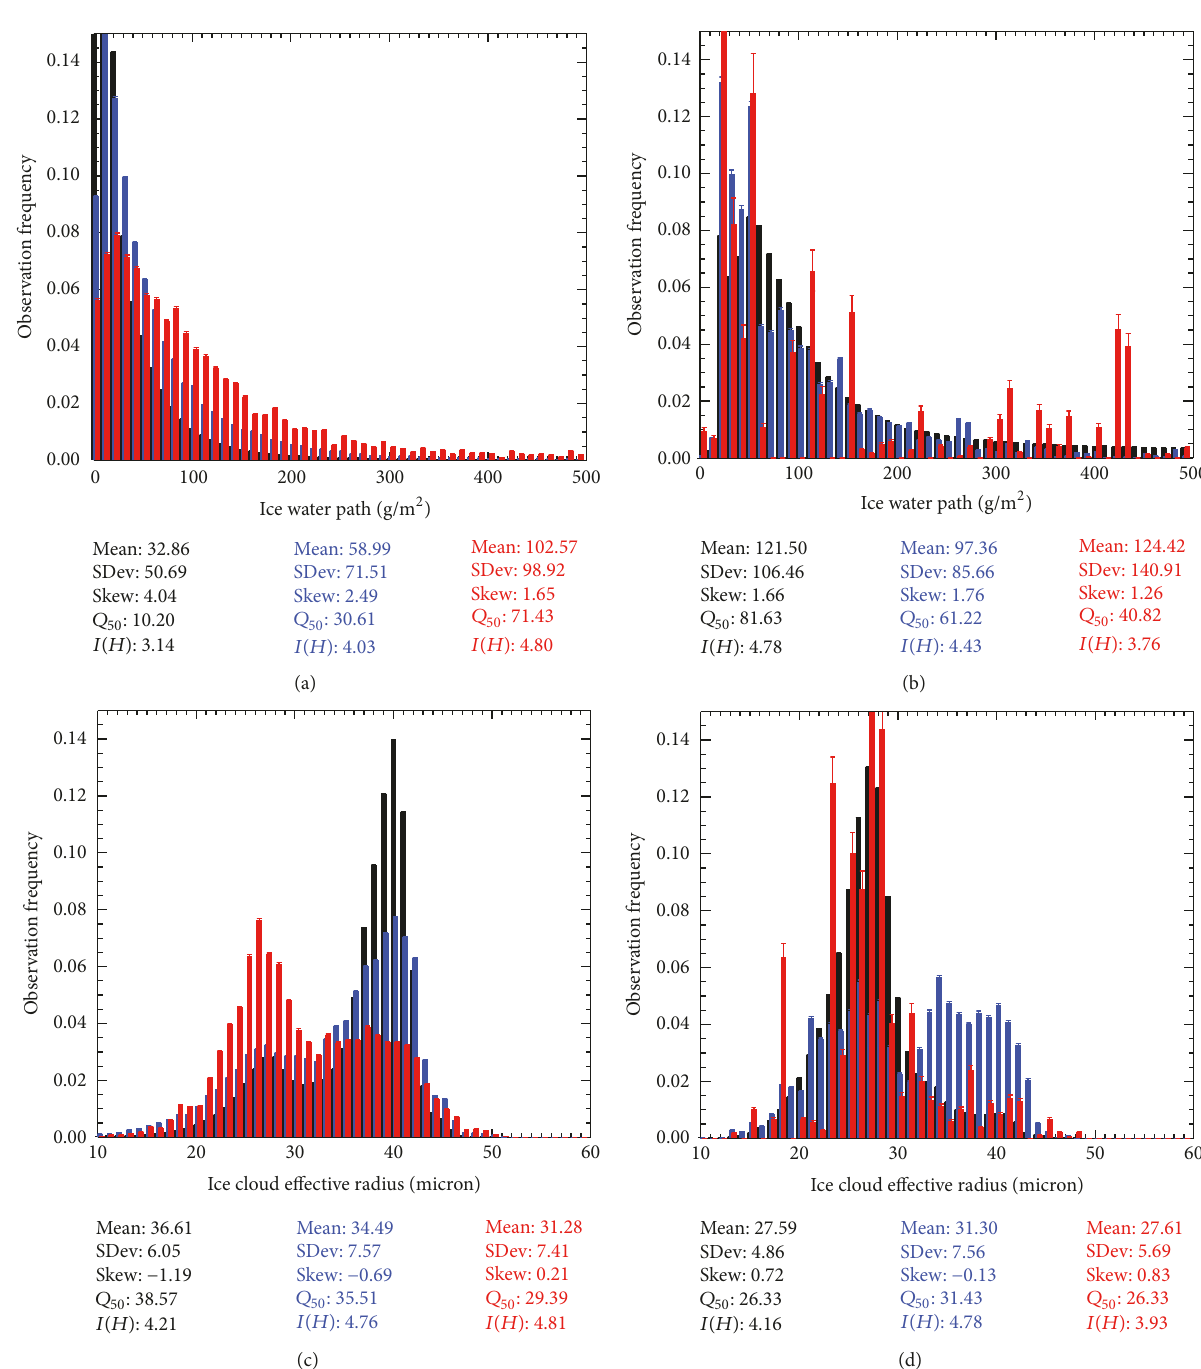
Figure 8: Observation histograms of ice water path (a, b) and ice cloud effective radius (c, d) for all cloud observations (a, c) and deep ice clouds only (b, d). Black colour represents pristine background conditions, blue moderate dust loading, and red the high dust loading